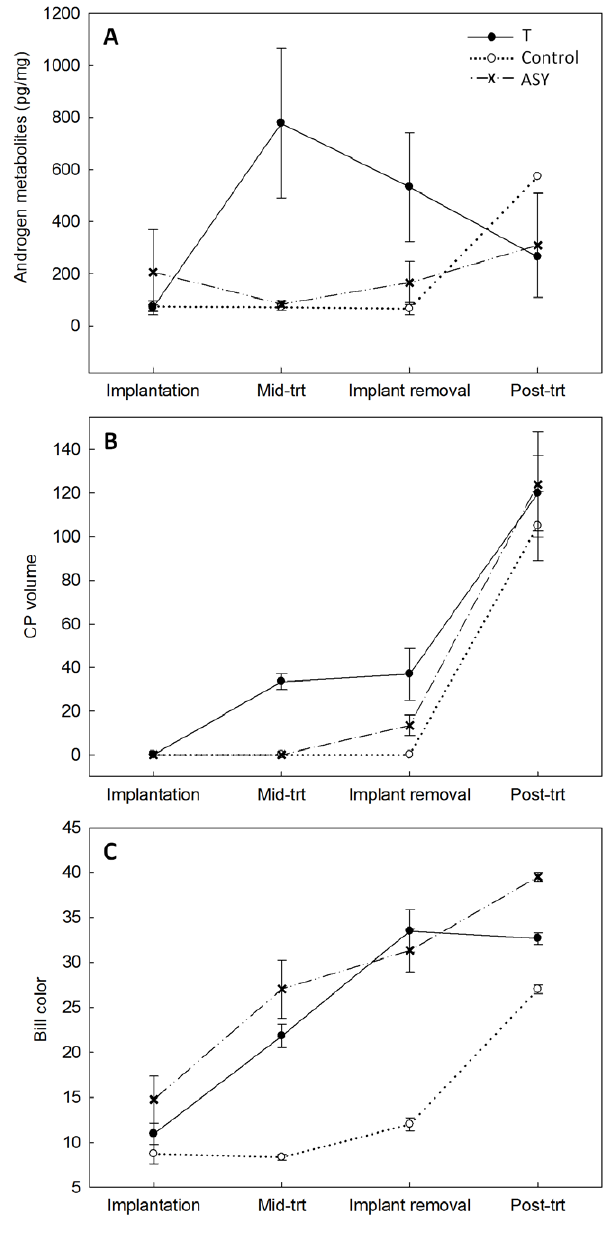
Figure 1. Treatment effects on androgen metabolite concen- trations (A), cloacal protuberance volume (B), and bill color (C). Changes in mean response 6 SE for second-year testosterone (T) and control implanted males, and unmanipulated after-second year (ASY) males at implantation, the mid-treatment recapture, implant removal, and the post-treatment